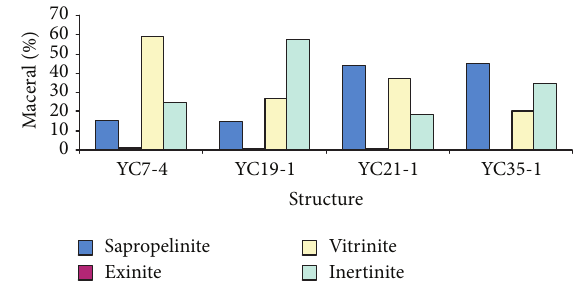
Figure 4: The maceral characteristics of the marine source rocks in the Sanya formation in different structures of the Qiongdongnan